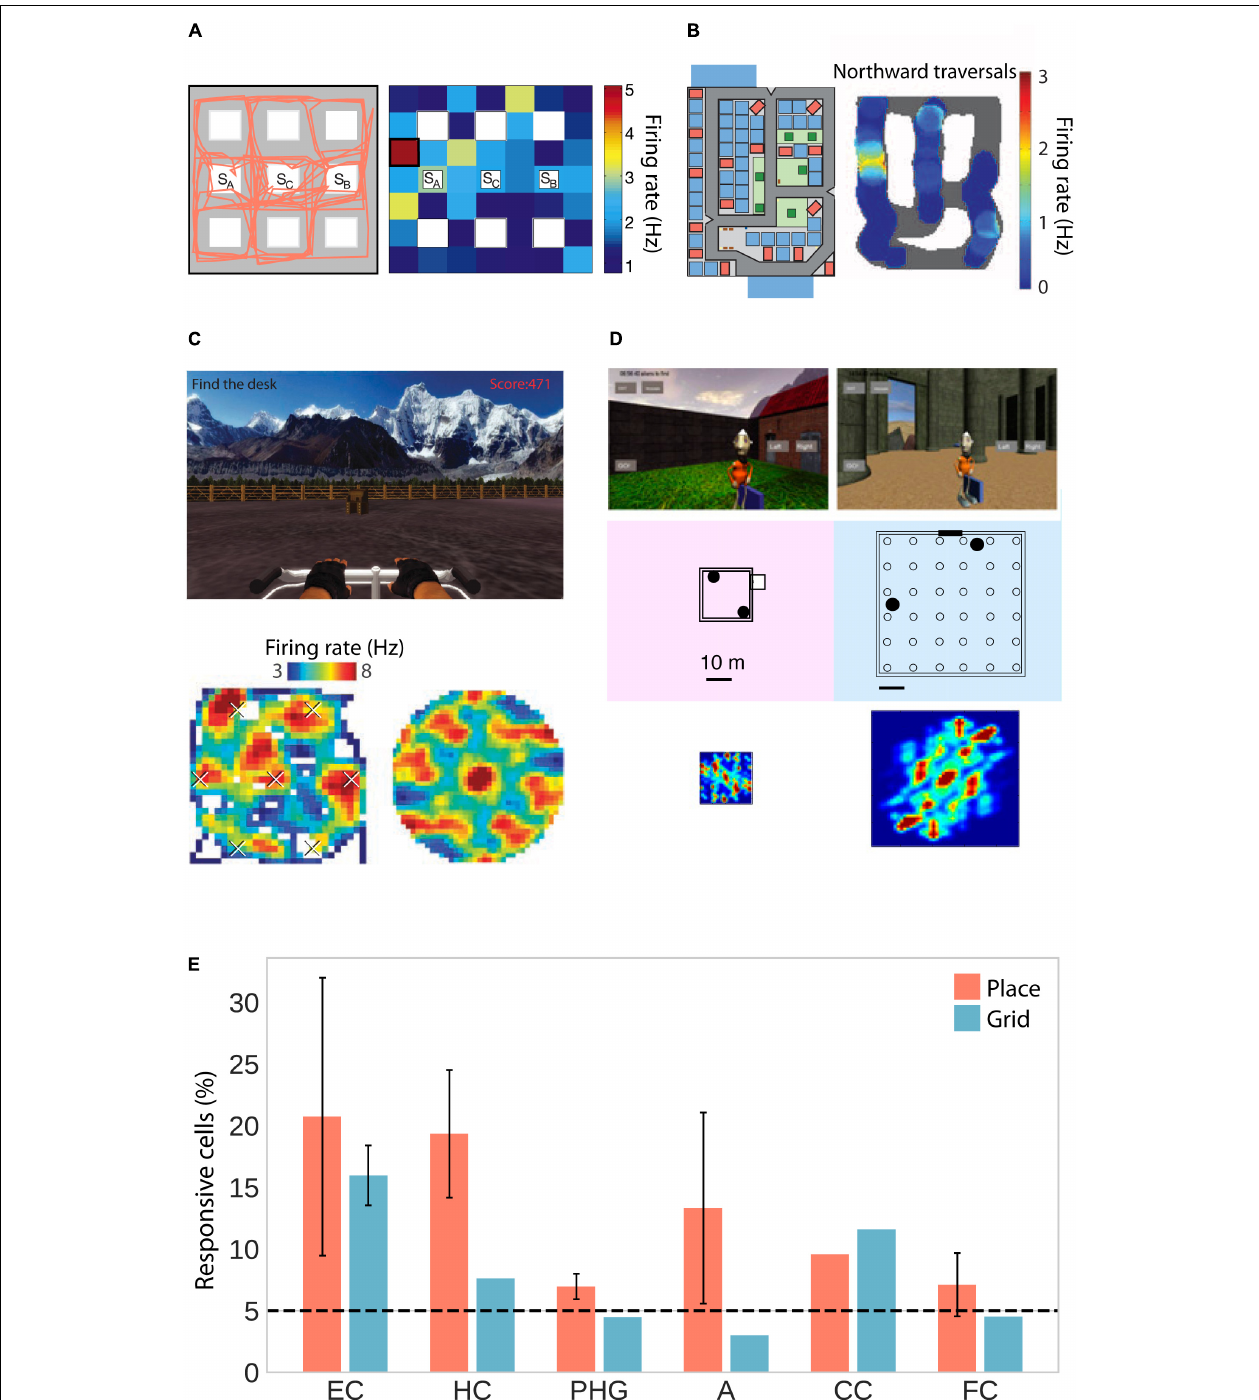
FIGURE 1 | Place and grid cell activity in humans. (A) Traveled path (left) and firing rate map of an exemplary place cell ( right ) in a city block environment. Adapted with permission (Ekstrom et al., 2003) from Springer Nature. (B) City environment ( left ) and firing rate map for an exemplary unidirectional place cell firing only during northward traversals ( right ). Adapted with permission (Miller et al., 2013) from Science. (C) Open-field environment ( top ), firing rate map ( lower left ), and spatial autocorrelation function ( lower right ) of an exemplary grid cell. Adapted with permission (Jacobs et al., 2013) from Springer Nature. (D) Small ( left ) and large ( right ) virtual arena with corresponding autocorrelation functions showing small and large grid spacing, respectively. Adapted with permission (Nadasdy et al., 2017) from PNAS. (E) Percentage of place- and grid-responsive cells in the entorhinal cortex (EC), hippocampus (HC), parahippocampal gyrus (PHG), amygdala (A), cingulate cortex (CC), and frontal cortex (FC). Data were summarized from Ekstrom et al. (2003); Jacobs et al. (2013), Miller et al. (2013), and Nadasdy et al. (2017). Standard error of the mean is shown if more than one of the studies reported data for a given brain region.